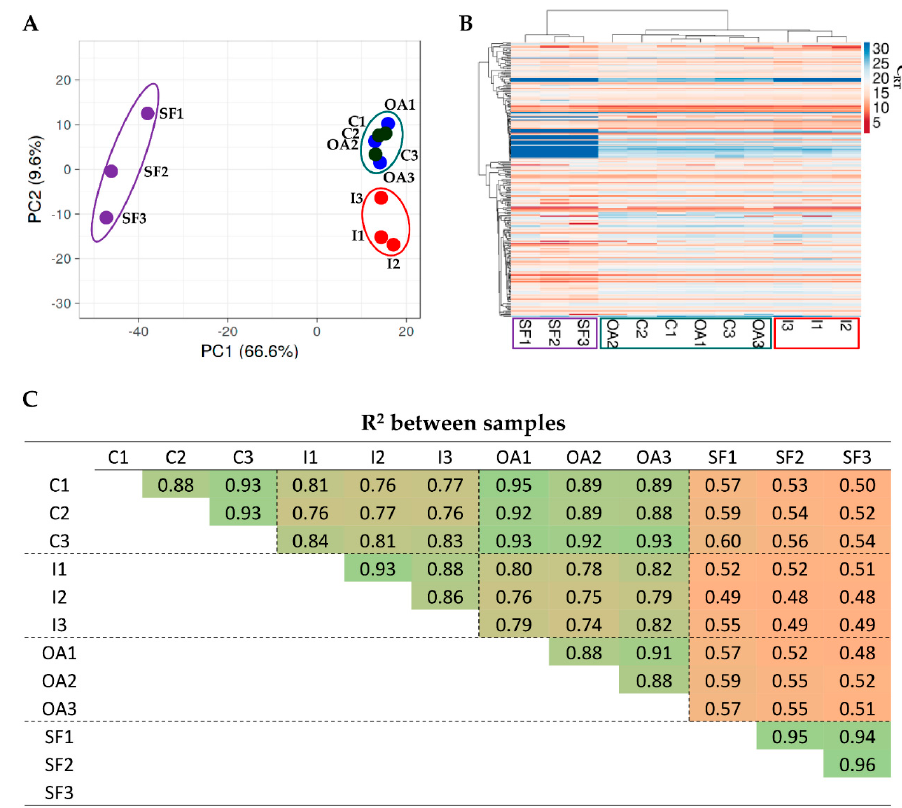
Figure 2. EV-miRNA fingerprint analysis between conditions. ( A ) Principal component analysis of normalized C RT values of miRNAs. X and Y axis show principal component 1 and principal compo- nent 2 which explain 66.6% and 9.6% of the total variance. ( B ) Heat map of hierarchical clustering analysis of normalized C RT values of detected miRNAs with sample clustering tree at the top. The color scale reflects the absolute expression levels: red shades = high expression levels and blue shades = low expression levels. Missed calls were set as C RT = 40. ( C ) Correlation analysis of the C RT values of miRNAs between samples after global mean normalization. A color scale relative to the amount of the R 2 value is presented. Green boxes for higher R 2 values, red boxes for lower R 2 values. To attribute a biological significance to detected EV miRNAs, several parameters were considered. Initially, the first quartile of expression was identified after C RT median calculation since, in MSC-EVs, even for abundant miRNAs no more than one copy per EV is present [28], and a minimal ratio of 100 EVs per target cell is needed to grant efficient miRNA transfer [29]. This led to a list of 63 miRNAs, covering 96.1% of the detected ge- netic message (Supplementary Table S2). Sifting experimentally validated miRNA– mRNA interactions for each of the first-quartile miRNAs (Supplementary Table S3), and 1364 univocal genes were identified (Supplementary Table S4). To reliably frame stable or differential expression, those miRNAs with a C RT SD > 1 in at least one of the conditions were excluded. This led to 19 differentially expressed molecules (fold > 2 or <0.5, adjusted p -value ≤ 0.05) with respect to C conditions (Table 1): 3 downregulated miRNAs in the I samples targeting 172 genes (Supplementary Table S4); 13 downregulated (418 targets) and 3 upregulated miRNAs (97 targets) in the SF samples. To remove conflicting regula- tions, SF-specific down/upregulated miRNA targets were cleared of those present in both lists, resulting in 395 and 74 univocal targets for down and upregulated miRNAs, respec- tively (Supplementary Table S4).